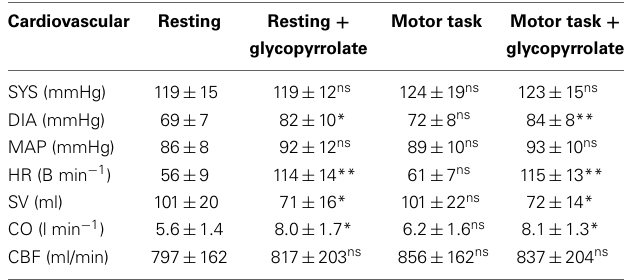
Table 2 | Cardiovascular